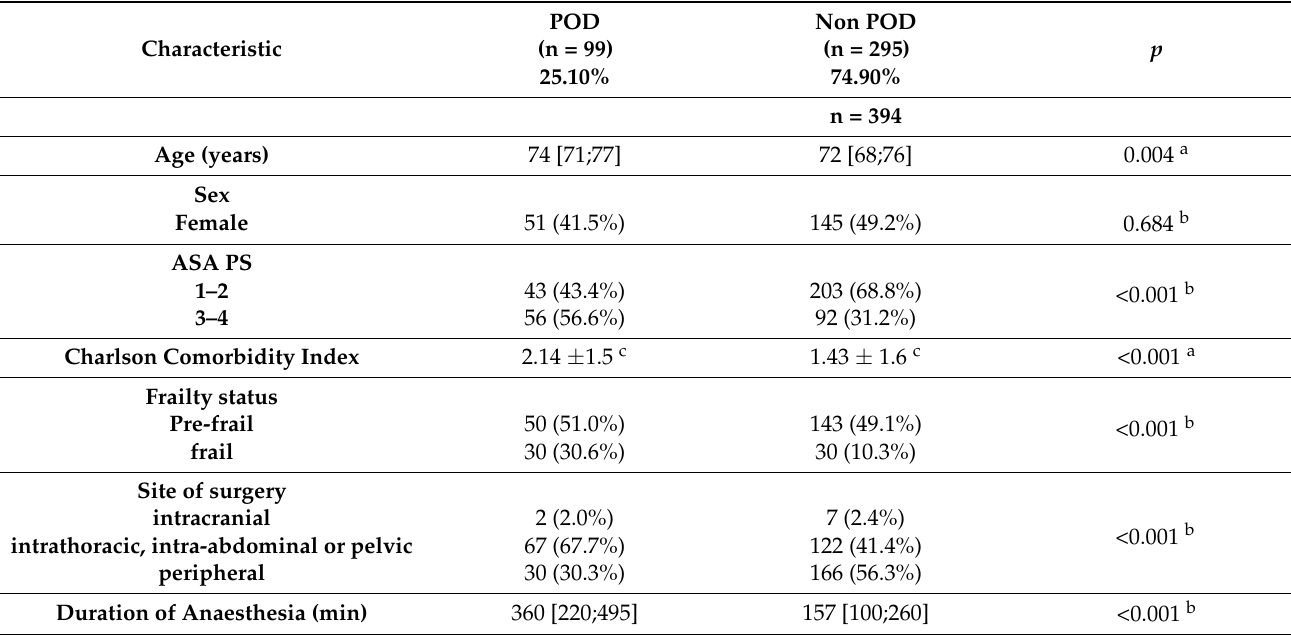
Table 1. Patient characteristics (n =